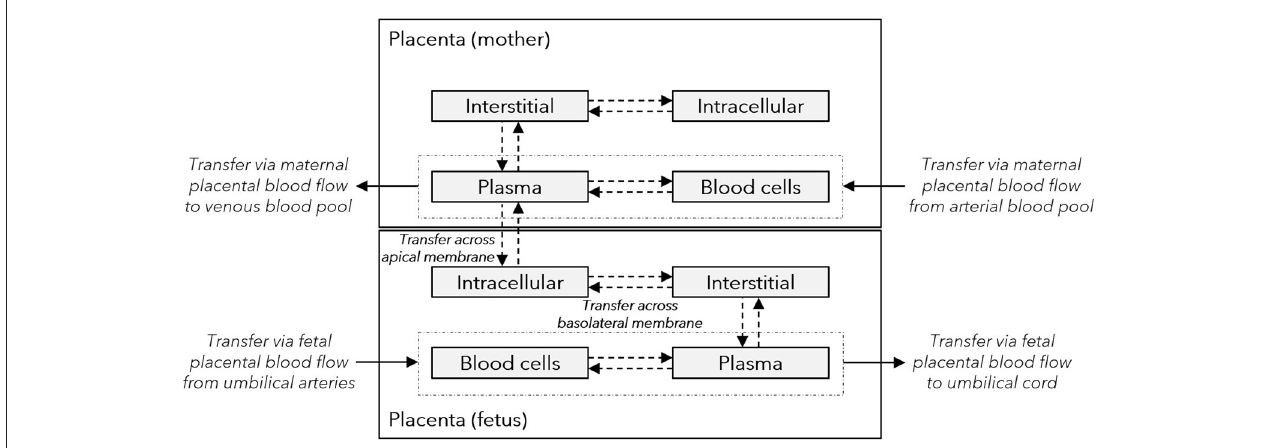
FIGURE 2 | Sub-structure of the placenta barrier in the pregnancy PBPK models. Gray boxes represent sub-compartments of the placenta structure implemented in the pregnancy PBPK model; dash-dotted boxes represent the vascular space; solid arrows denote drug transport via the organ blood flow; and dashed arrows denote drug transport via passive diffusion. The intracellular compartment in the fetal placenta represents the (syncytio)trophoblasts with the apical membrane facing toward the maternal plasma compartment and the basolateral membrane toward the fetal interstitial compartment. PBPK, physiologically based